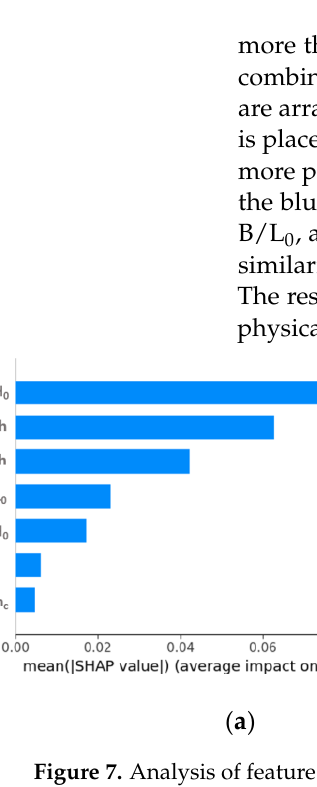
Figure 7. Analysis of feature importance. ( a ): SHAP feature importance. ( b ) Summary plot (feature effects).